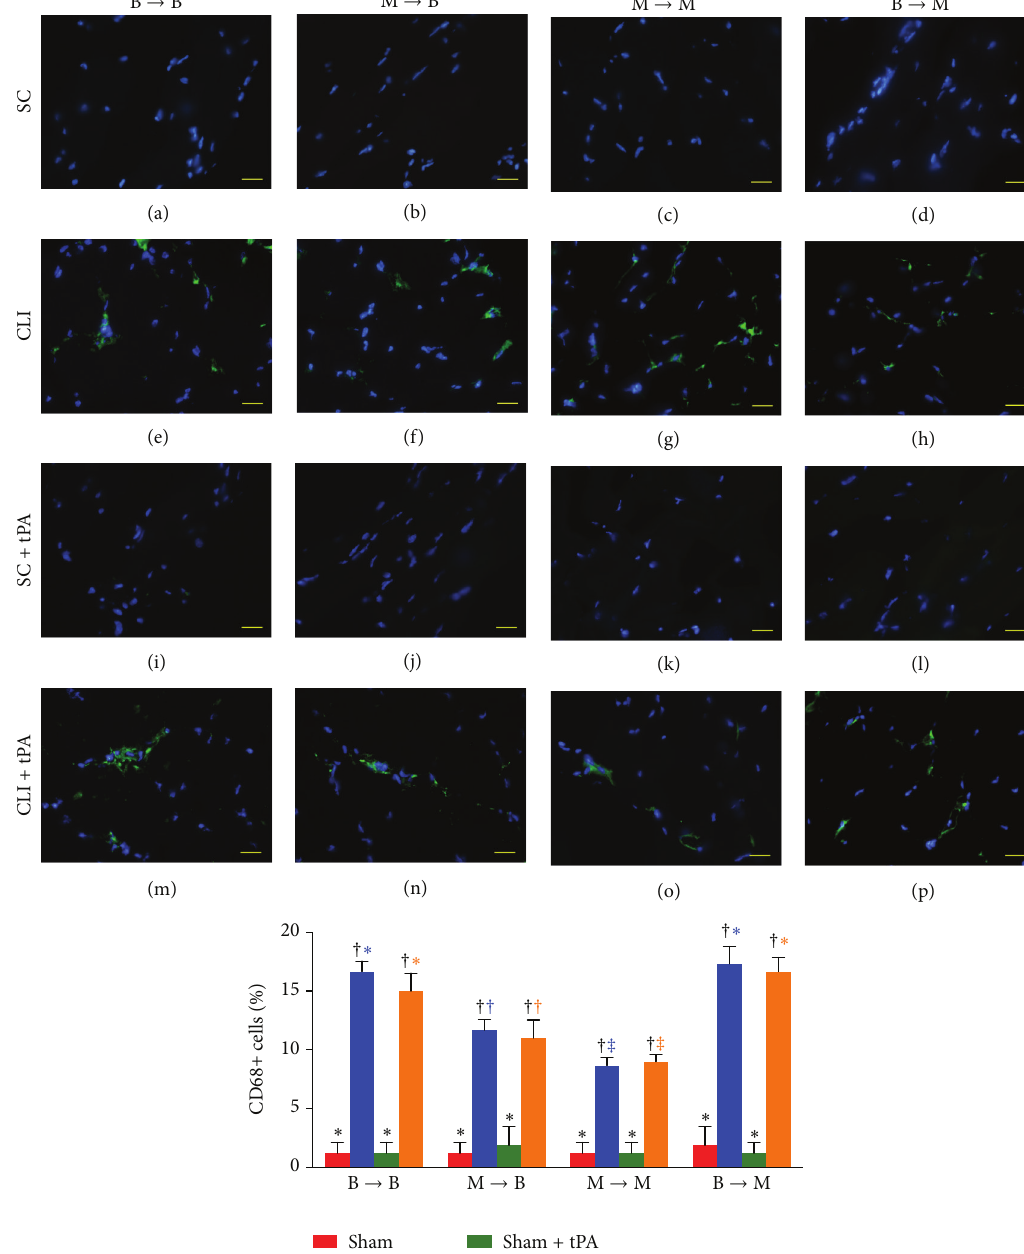
Figure 14: Immunofluorescent (IF) microscopic findings (400x) of macrophages (CD68+ cells) in ischemic quadriceps at day 14 after critical limb ischemia (CLI) induction. (a–p) IF microscopic findings of CD68+ cells in ischemic area in four treatment conditions of four groups. (1) Statistical analysis for subgroups of each group. (1) In B → B group, subgroups with different black symbols ( ∗ , † ), 𝑝 < 0.05 . (2) In M → B group, subgroups with different black symbols ( ∗ , † ), 𝑝 < 0.05 . (3) In M → M group, subgroups with different black symbols ( ∗ , † ), 𝑝 < 0.05 . (4) In B → M group, subgroups with different black symbols ( ∗ , † ), 𝑝 < 0.05 . (2) Statistical analysis for group comparison with respective treatment condition. (1) In SC subgroup (red bar chart), 𝑝 > 0.05 . (2) In CLI subgroup (blue bar chart), groups with different blue symbols ( ∗ , † , and ‡ ), 𝑝 < 0.05 . (3) In SC + tPA subgroup (green bar chart), 𝑝 > 0.05 . (4) In CLI + tPA subgroup (orange bar chart), groups with different orange symbols ( ∗ , † , and ‡ ), 𝑝 < 0.05 . All statistical analyses were performed by one-way ANOVA followed by Bonferroni multiple comparison post hoc test. SC = sham control; tPA = tissue plasminogen activator. 𝑛 = 6 for each